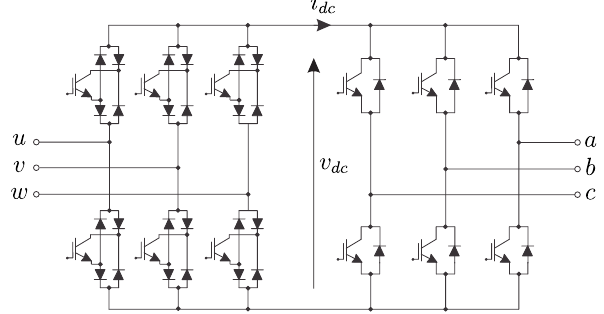
Figure 25. Sparse matrix